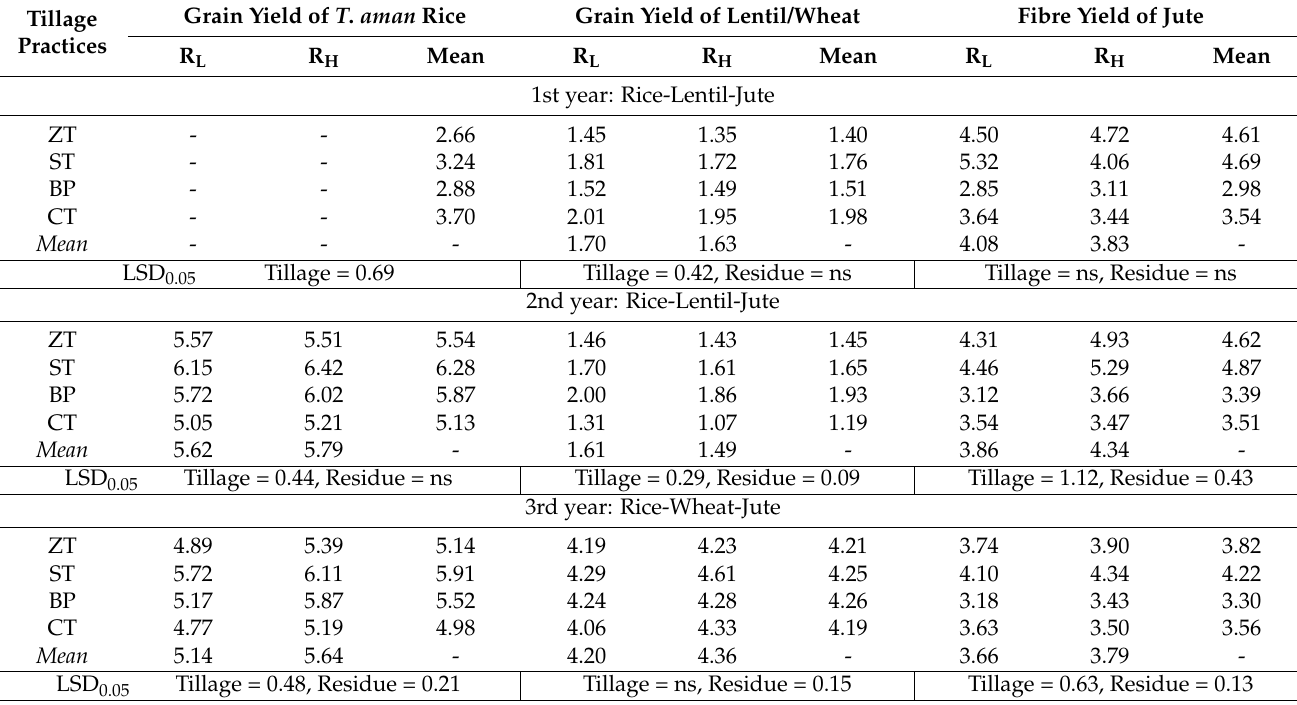
Table 2. Effect of tillage practices and crop residue retention on yield (t ha − 1 ) of different crops in the Rice-lentil/wheat-jute cropping system over three years. Values are the means of four